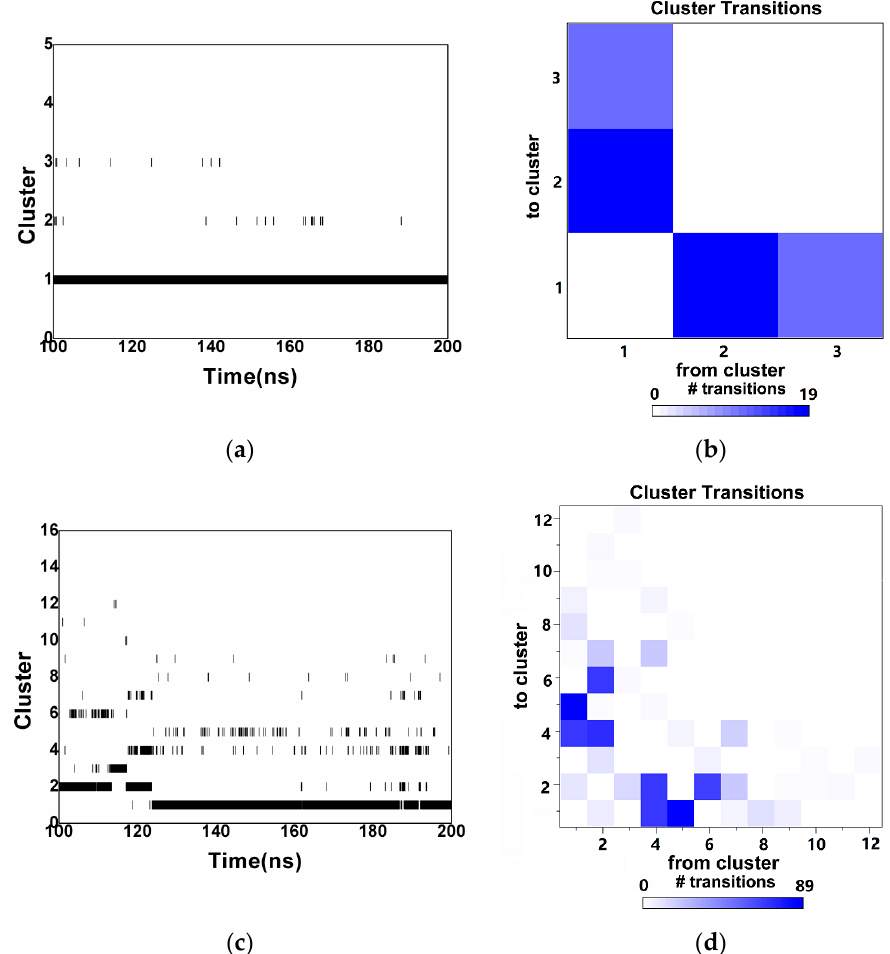
Figure 2. ( a ) The cluster distributions of MGAM ‐ TW, ( b ) the cluster transitions of MGAM ‐ TW, ( c ) the cluster distributions of MGAM ‐ WA, and ( d ) the cluster transitions of MGAM ‐ WA. Table 1. The cluster size and the representative conformations of TW.